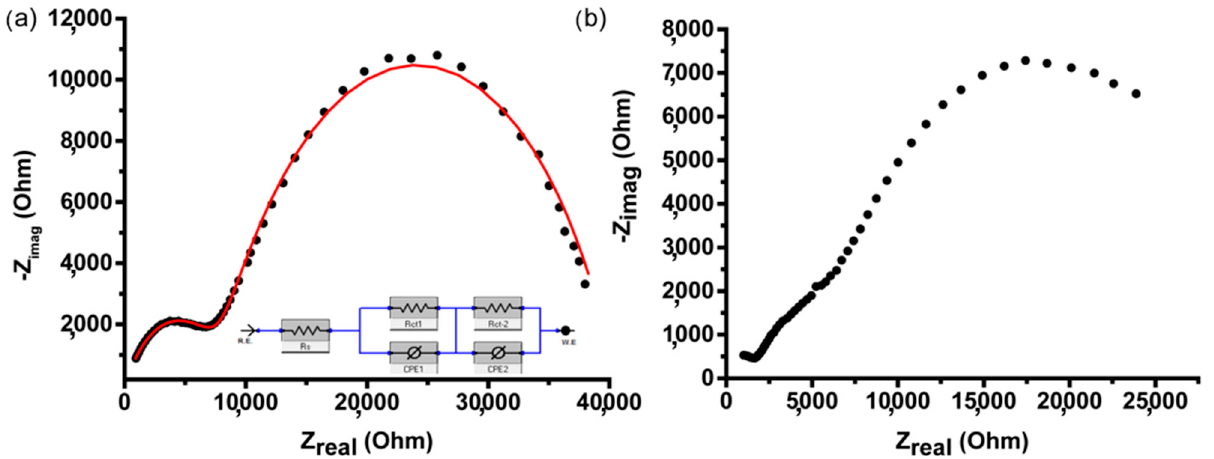
Figure 7. Impedance spectroscopy data. ( a )In the absence of glucose, equivalent circuit inserted; ( b ) ( b ) in the presence of 5 mM in the presence of 5 mM glucose.